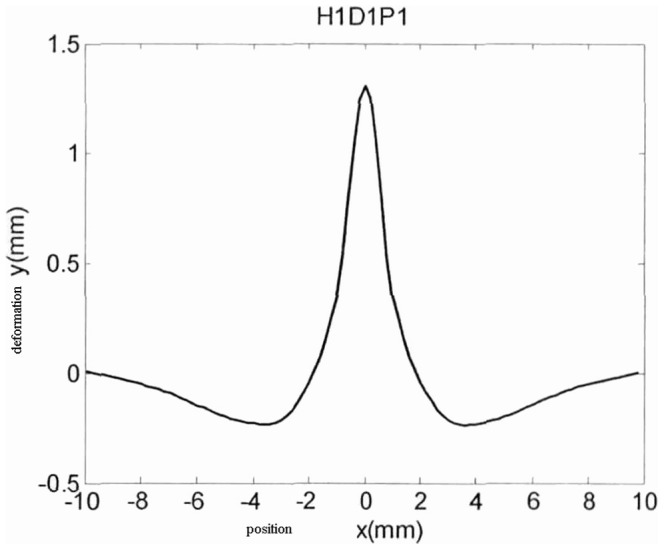
Finger deformation relative to position.